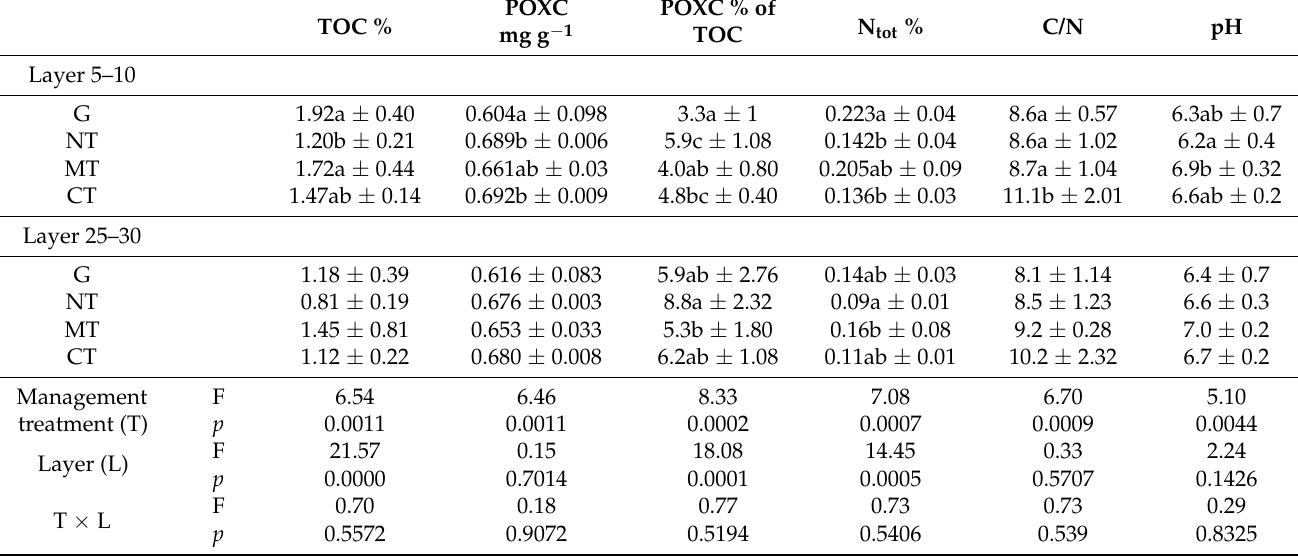
Table 5. Mean ( ± standard deviation) values of soil chemical properties in 2016 are presented. Letters indicate statistical differences in soil properties between management treatments according to Tukey post hoc test, which have to be read per column and per layer. Effects of management treatment (G, NT, MT and CT) and sampling layer (5–10 cm vs. 25–30 cm) on soil chemical properties as analysed with linear mixed-effects models (n = 12 per management treatment), where the F-statistics and p -values (values ≤ 0.05 are in bold) for the factors and their interactions are reported in the lower part of the